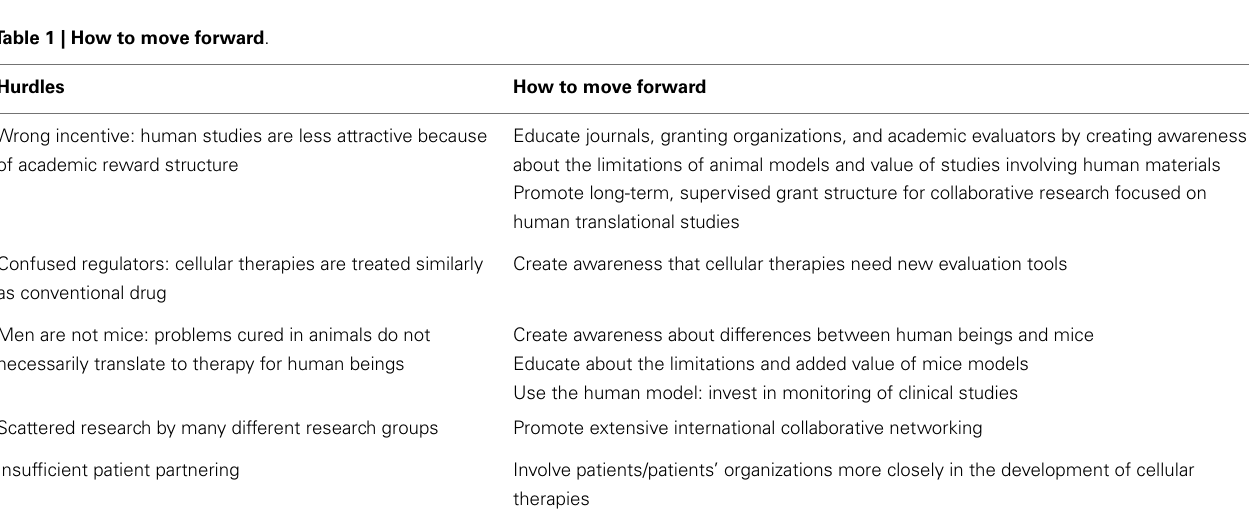
Table 1 | How to move forward